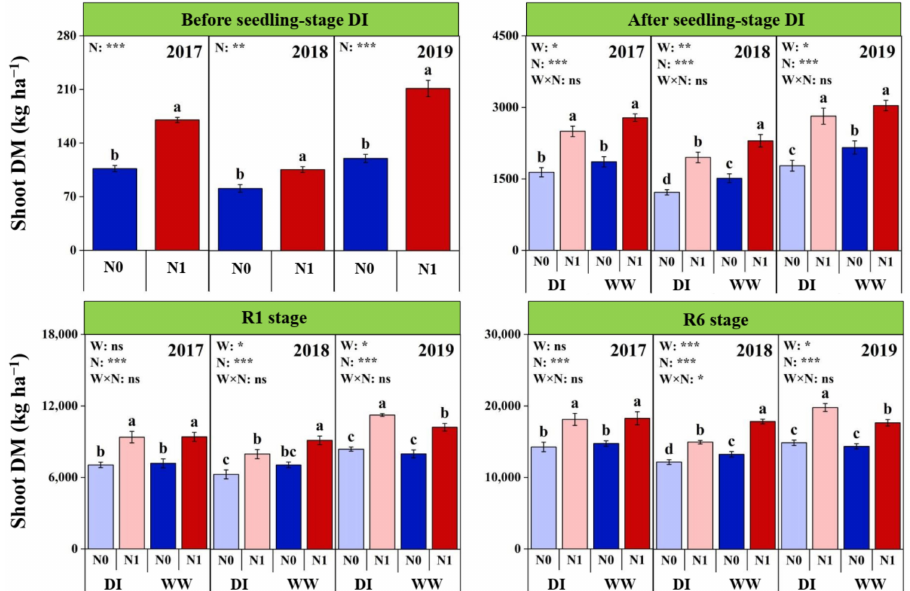
Figure 1. Effects of nitrogen fertilization (N) and seedling-stage water management regime (W) on shoot dry biomass (DM) of maize plants at different growth stages in 2017–2019. Note: *, ** and *** indicate significance at p < 0.05, p < 0.01 and p < 0.001, respectively, and ns indi- cates non-significance ( p > 0.05). Different letters above bars indicate significant differences between treatments ( p <